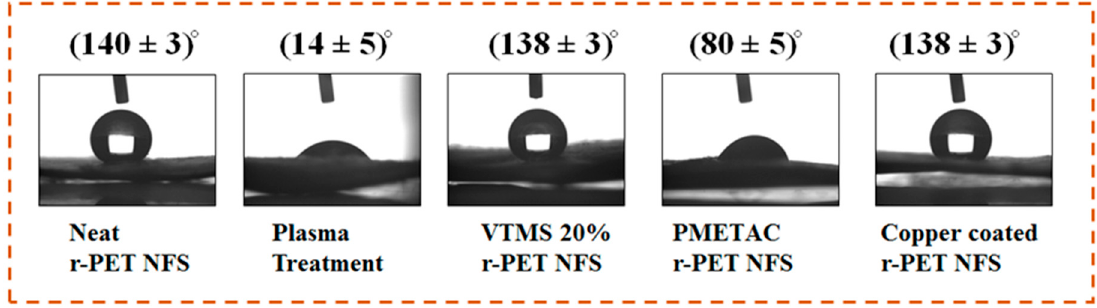
Figure 5. Water contact angle analysis of neat r-PET nanofibers and copper-coated r-PET nanofibers.